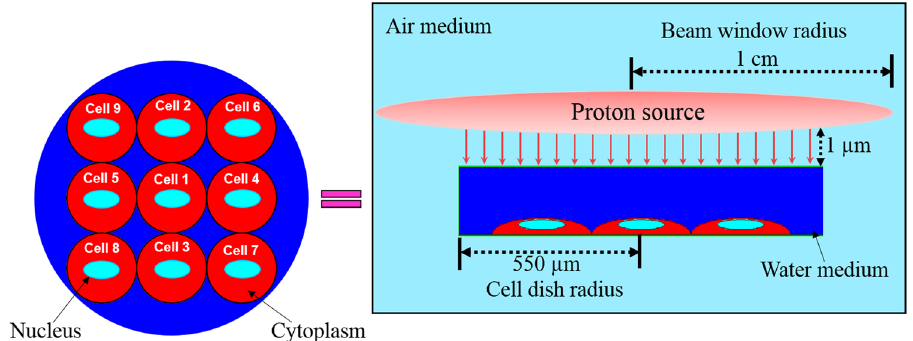
Figure 1. Schematic representation of the modeled cell array containing nine cells covered with a cylindrical medium (composed of water) and exposed to a proton